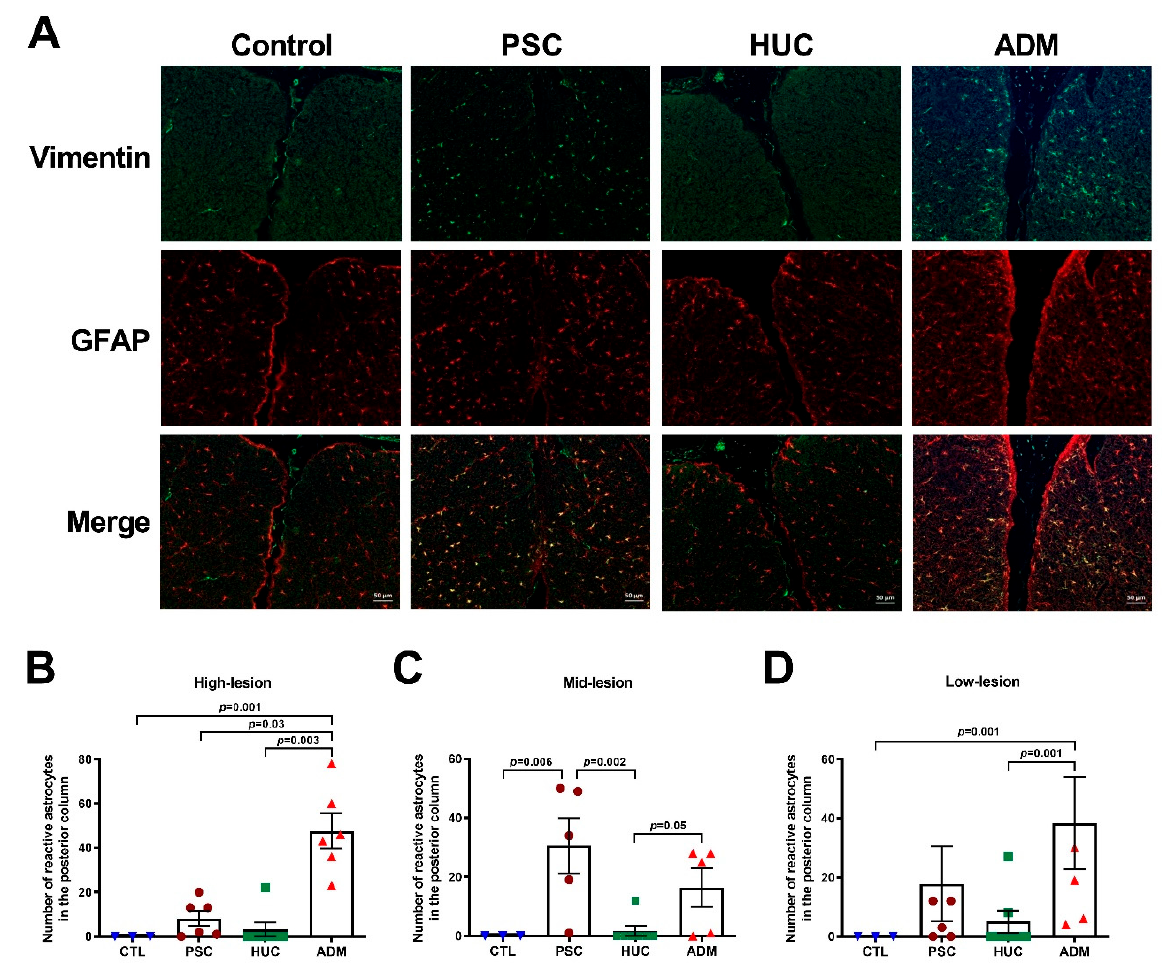
Figure 6. Reactive astrocytes are lower in spinal cord posterior columns of the HUC patch at defect sites than for PSC and HUC patch repair groups. ( A ) Immunofluorescent detection of reactive astrocytes in spinal cord posterior columns of control lambs and in PSC, HUC, and ADM patch defect repair groups by staining for vimentin and anti-glial fibrillary acidic protein (GFAP). ( B ) Quantification of the number of reactive astrocytes present in high-lesion tissue sections at defect repair sites. ( C ) Quantification of the number of reactive astrocytes present in mid-lesion tissue sections at defect repair sites. ( D ) Quantification of the number of reactive astrocytes present in low-lesion tissue sections at defect repair sites. All graphical data are shown as mean ± s.e.m. p -values were determined by ANOVA, Kruskal–Wallis test using the two-stage linear step-up procedure of Benjamini, Krieger, and Yekutieli.